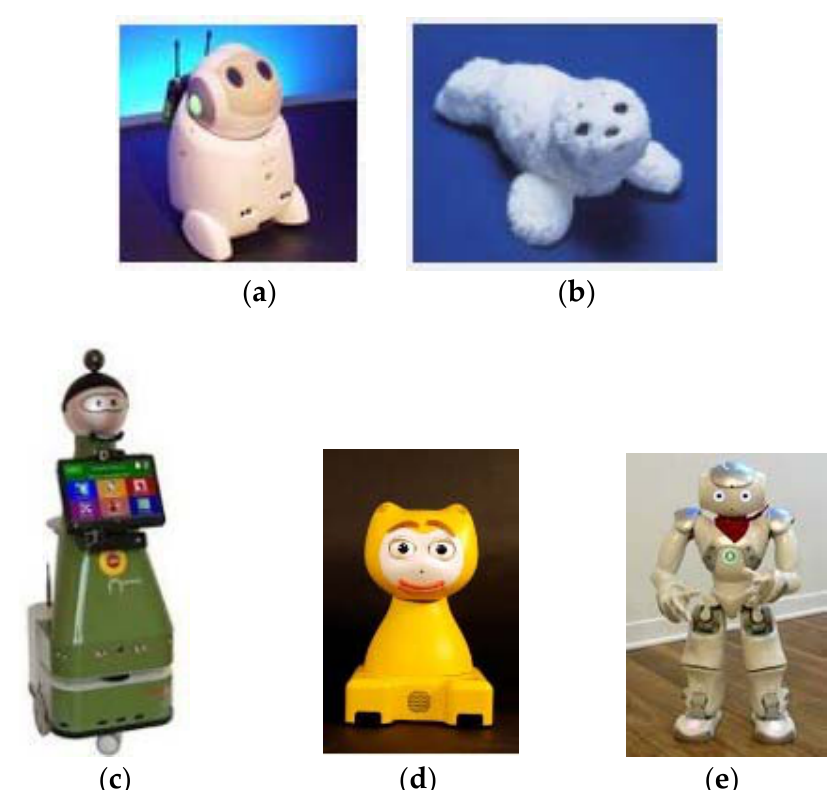
Figure 5. Examples of sociorobots. ( a ) PaPeRo: www.materialicious.com/2009/11/communication- robot-papero.html; ( b ) PARO: www.roboticstoday.com/robots/paro; ( c ) Mobiserv: www.smart-homes. nl/Innoveren/Sociale-Robots/Mobiserv; ( d ) i-cat: www.bartneck.de/2009/08/12/photos-philips-icat- robot; ( e ) NAO: